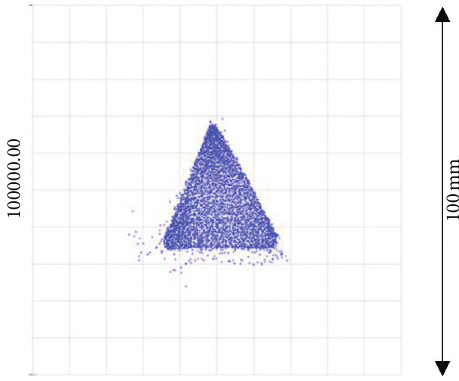
Figure 6: Spot diagram representing ray distribution in D plane ( z � 500mm).